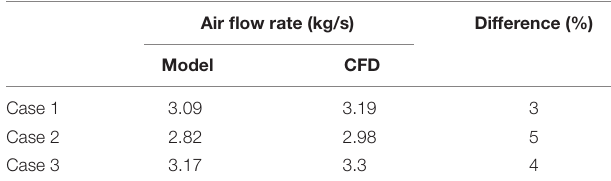
TaBle 3 | simulation results vs. cFD